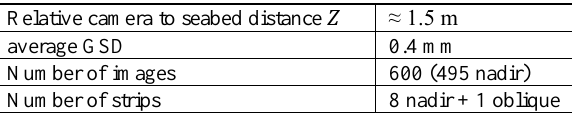
Table 1. Summary of the real case dataset used for generating the simulated